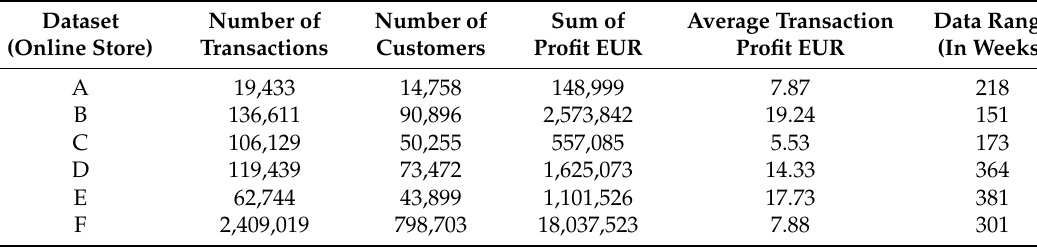
Table 2. Summary information about individual online stores and available